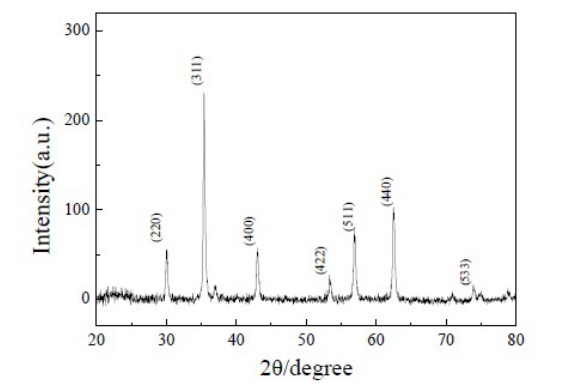
Figure 1: The XRD spectrum of Fe 3 O 4